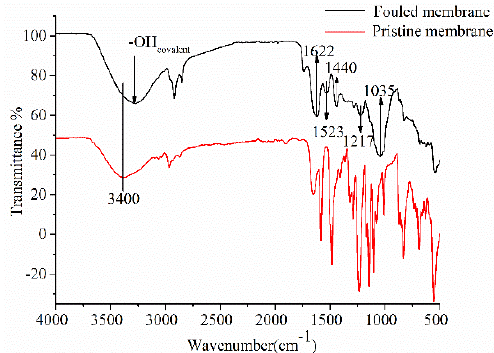
Figure 5. FTIR spectra of pristine and fouled membranes.